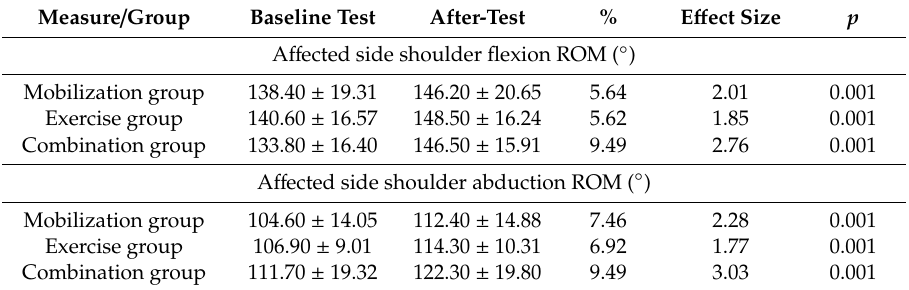
Table 3. Changes in the a ff ected side shoulder ROM and SPADI point before and after